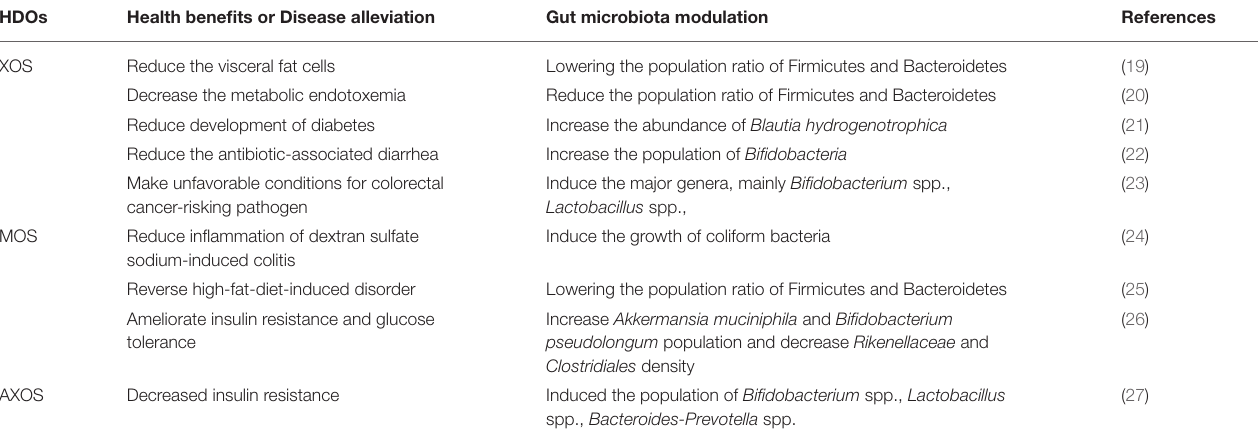
TABLE 2 | Role of HDOs in health promotion and gut microbiota